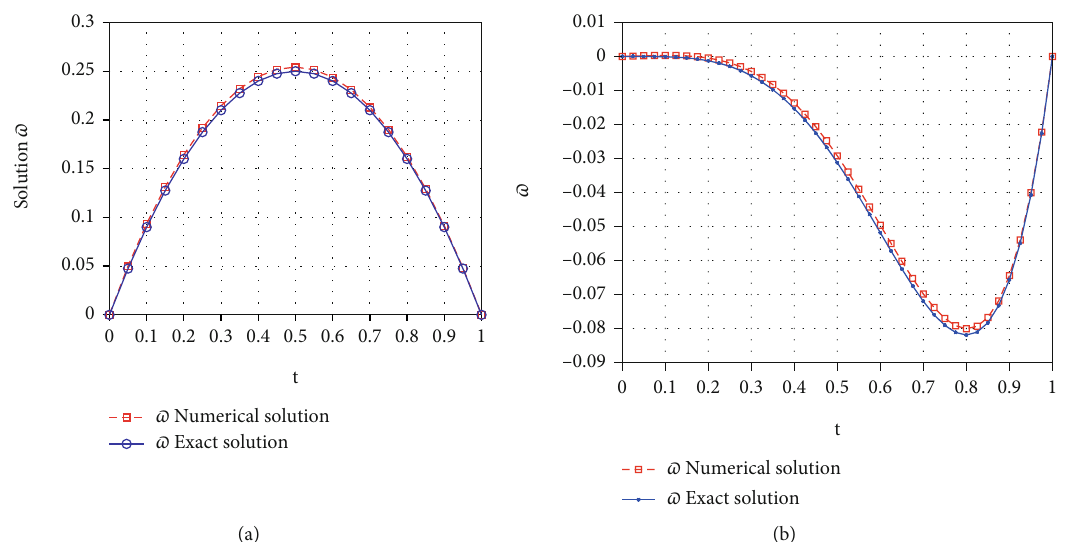
Figure 1: A comparison between exact and approximate solutions: (a) Example 3 when γ = 3/2 , ℘ = 1/2 , and h = 1/20 . (b) Example 4 when γ = 3/2 and h = 1/40 .